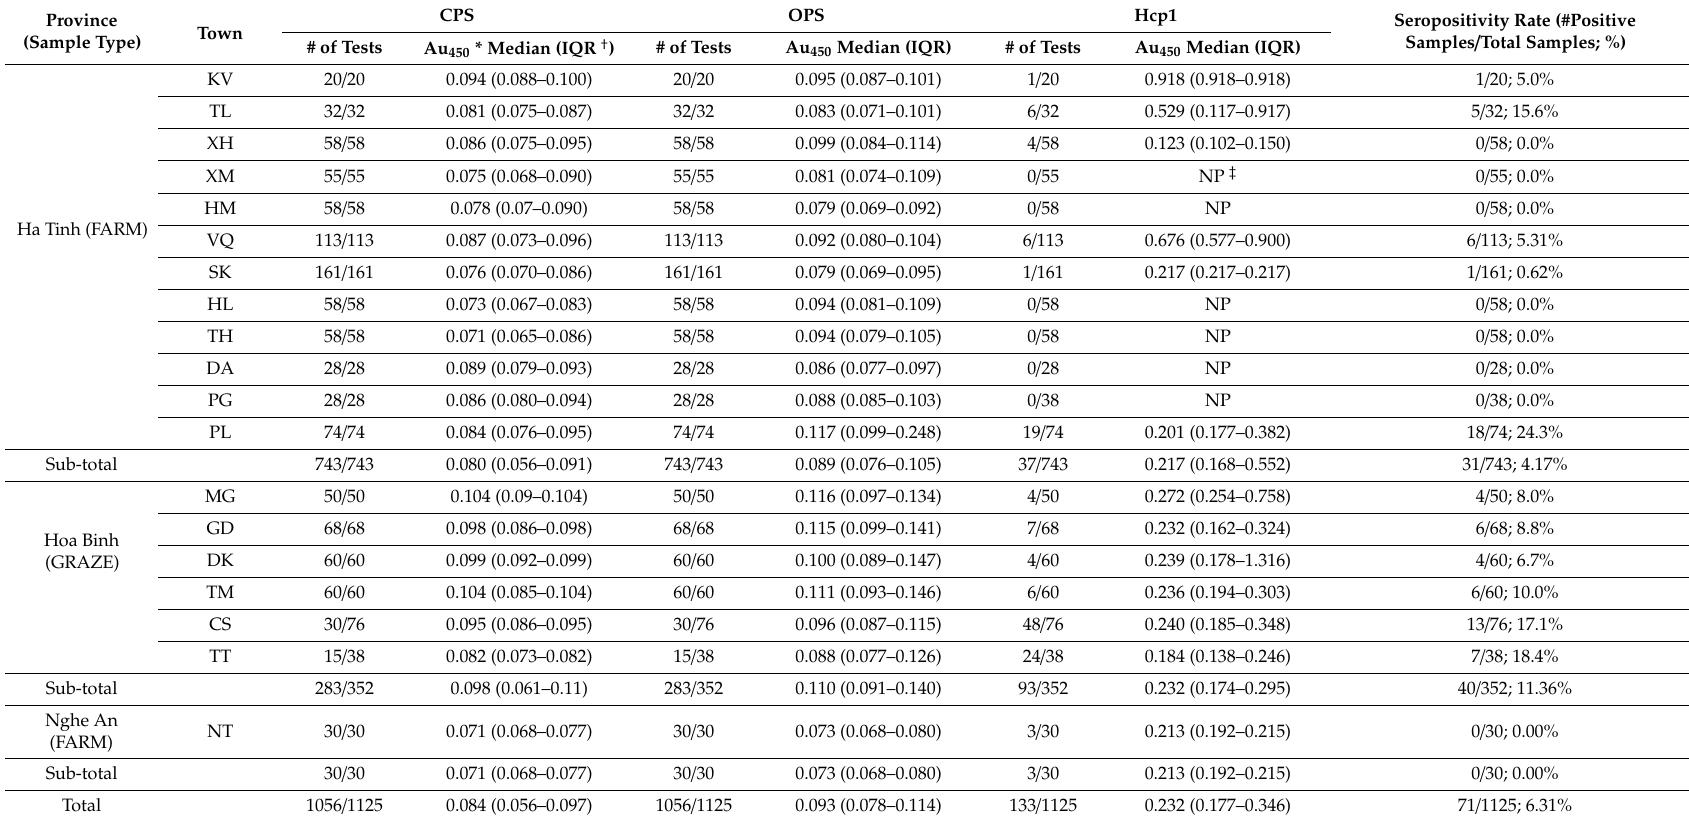
Table 2. ELISA assay results summary per antigen and